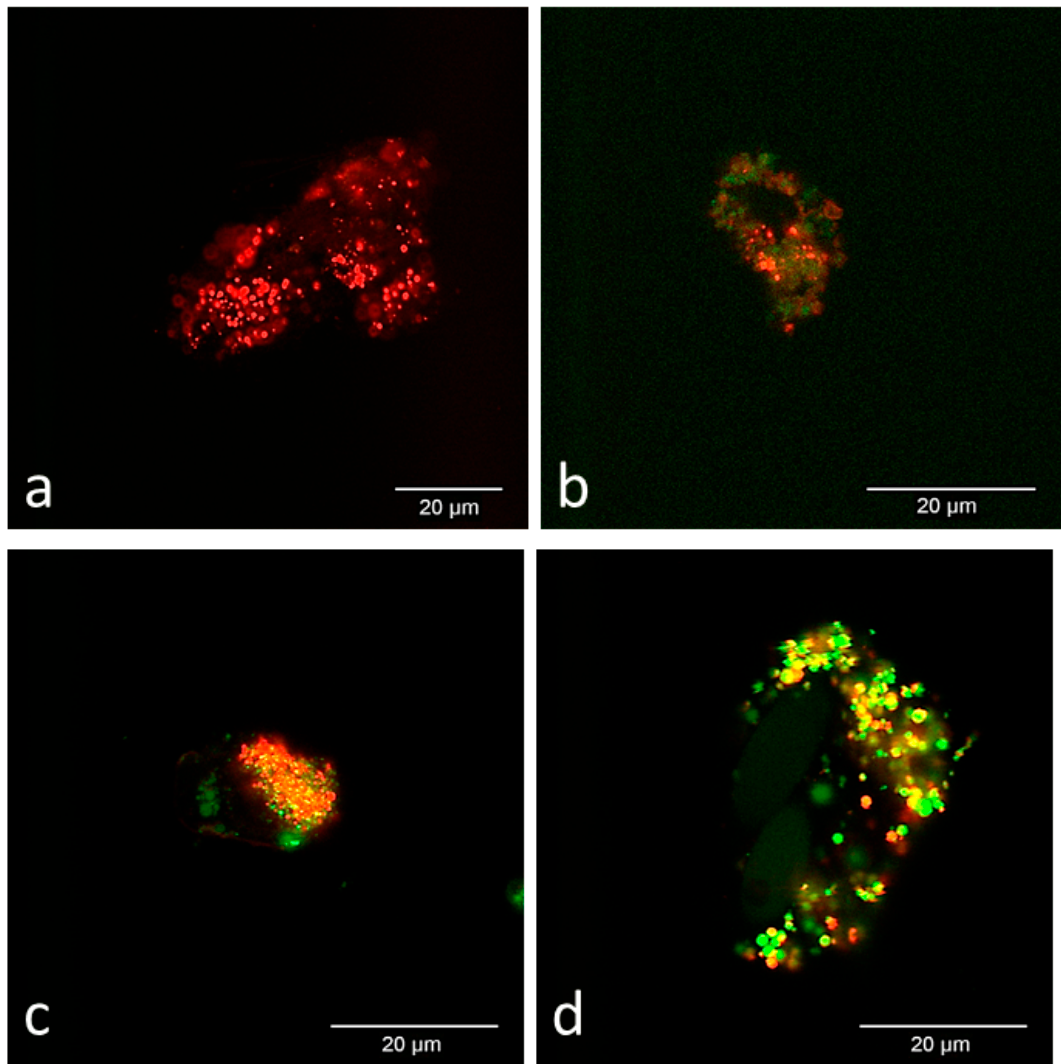
Figure 2. Representative confocal microscopy images of in vitro cultured prepared CB-MSCs. ( a ) Day 1, ( b ) day 7, ( c ) day 14, and ( d ) day 33. All images were captured using the same settings except for day 7 ( b ), which was captured with a higher sensitivity setting for green to enhance early subtle green signal for demonstration purposes. CB-MSCs are clumped in day 1 ( a ) and day 33 ( d ). In all images, individual CB-MSCs measured between 15–20 µ m lengthwise and 10–15 µ m widthwise. On day 1 ( a ), many red fluorescent dots were uniformly distributed on phospholipid membranes with very weak green signal. On day 7 ( b ), CB-MSCs maintained red signal but also began to produce stronger green signal as dots or generalized throughout the cytoplasm. On day 14 ( c ) and day 33 ( d ), CB-MSCs remained similar to day 7 ( b ) but had brighter green signal of the cytoplasm and organelles. On day 33 ( d ) green signal was more intense than previous days. Colocalization of red and green signal varied between individual cells but was typically low to moderate.